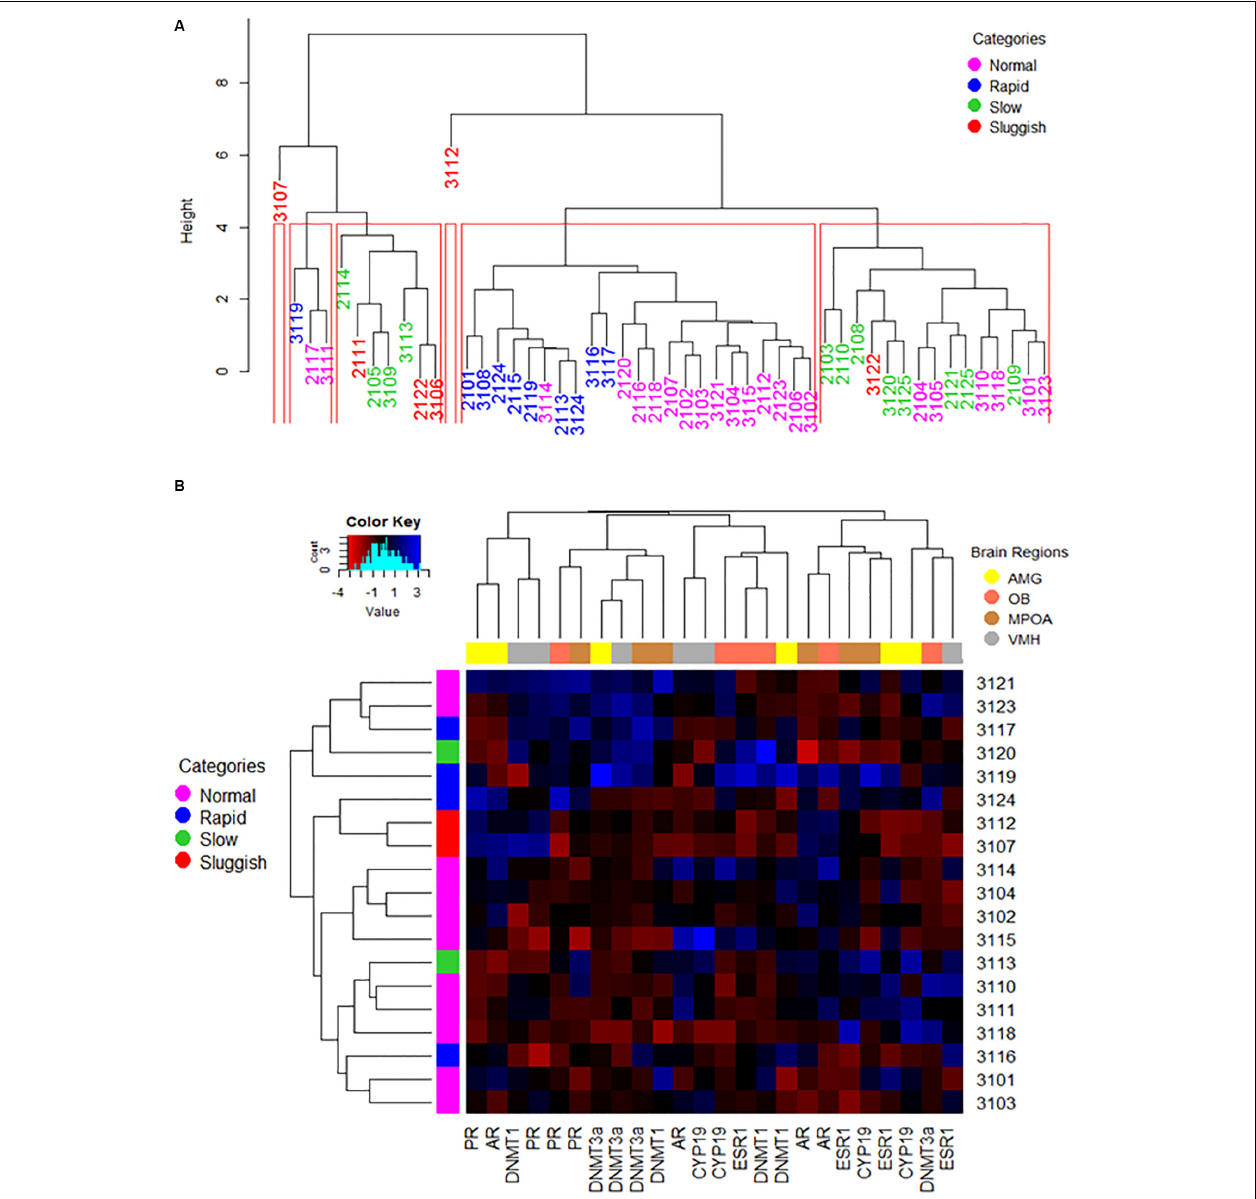
FIGURE 4 | The way copulatory parameters and the expression of copulation relevant genes in pertinent brain limbic areas interact one another or altogether are not specific to either of the presumed EL-ejaculatory endophenotypes. (A) A complete linkage clustering dendrogram was used to estimate the degree of similarity among EL-phenotyped copulating males based on the way copulatory parameters interacted one another per phenotyped rat across the entire population of EL-phenotyped males ( n = 50). Notice that the population, including some sluggish copulating male rats, threshes mixed down through the branching pattern of the dendrogram until reaching the tip of the tree where individual rapid, normal slow and sluggish copulating males show different degrees of phenotype similarity depending upon the final location within the tree, and likely the frequency of each “endophenotype” across the population. In red, we show the animal clusters obtained at the cut point of 4 in height. Such clusters were used to compare the consistency of the EL-ejaculatory endophenotypes. Overall, the way copulatory parameters interact one another in most of the copulating males are more alike than distinct regardless of EL-ejaculatory endophenotype each were assigned to. (B) The combined used of a heat map and of an agglomerative complete linkage clustering dendrogram allowed us to evaluate the degree of similarity among EL-phenotyped copulating males based on the way brain regional patterns and levels of gene expression interacted with one another per phenotyped rat across the entire population of EL-phenotyped males ( n = 20). In this figure, the heat map color-codes (blue the highest levels; see color key on the upper left corner) the relative levels of expression of AR, ESR1, CYP19, PR, DNMT1 and DNMT3a genes, clustered based upon the degree of similarity per limbic structure (see upper right corner for the color code assigned to each region in the dendrogram placed at the upper border of the heatmap) and per EL-phenotyped male (dendrogram placed at the left side of the heat map). Numerals on the right correspond the numeric code assigned to each of the EL-phenotyped male, also color-coded based upon the presumed endophenotype assigned (see upper right corner in A ). Notice that gene expression clustering across the EL-phenotyped male population is ejaculatory endophenotype independent. The histogram on the upper left corner depicts the overall distribution of gene expression levels across the population of EL-phenotyped males. Amygdala: AMG; Olfactory bulb: OB; Medial preoptic area: MPOA; Ventromedial hypothalamus: VMH.